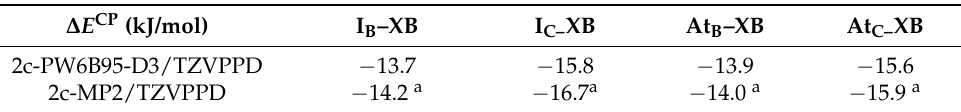
Table 4. Counterpoise-corrected 2c-PW6B95D3/TZVPPD and 2c-MP2/TZVPPD interaction energies ( ∆ E CP ) of the C 2 BX 3 ... C 2 BY 3 heterodimers with X, Y = I, At. ∆ E CP (kJ/mol) I B –XB At B –XB 2c-PW6B95-D3/TZVPPD a 2c-MP2/TZVPPD//2c-PW6B95-D3/TZVPPD